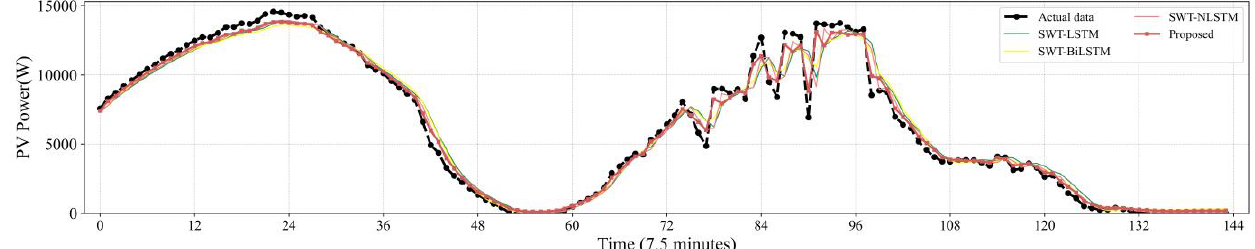
Figure 9. Contrasting the performance evaluation of the proposed model and LSTM and extensions.